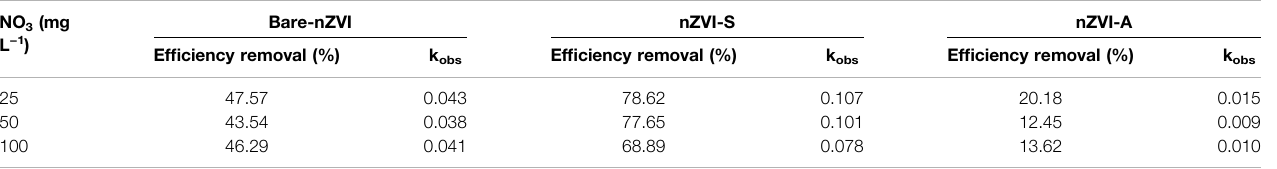
TABLE 4 | Observed pseudo- fi rst-order rate coef fi cient of nitrate reduction with nZVI. NO 3 (mg L − 1